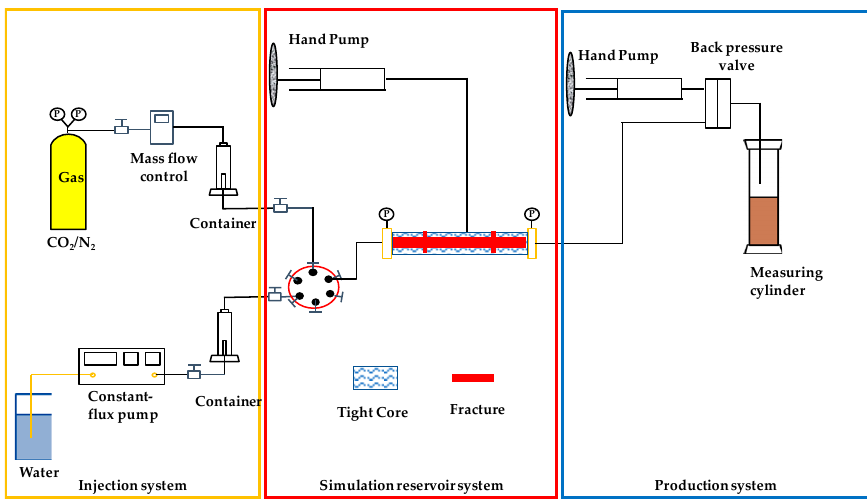
Figure 2. Basic fracture-matrix core.